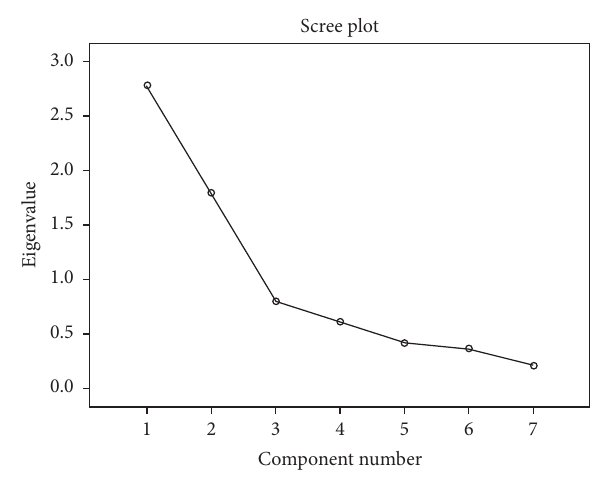
Figure 4: Cattell’s scree